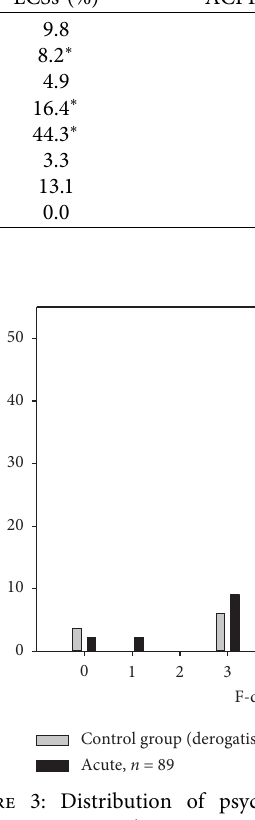
Figure 2: Distribution of psychiatric diagnoses (in percent) comparing LCS patients (with long-lasting pain) and the control group. Light bar: control group � the whole group of all chronic pain patients admitted to the pain management clinic ( n � 2,439; dark bar: LCSs, n � 61); w / o finding: psychiatrically inconspicuous regarding formal criteria. The distribution of both groups is not significantly different (chi-square test, p � 0 . 847).